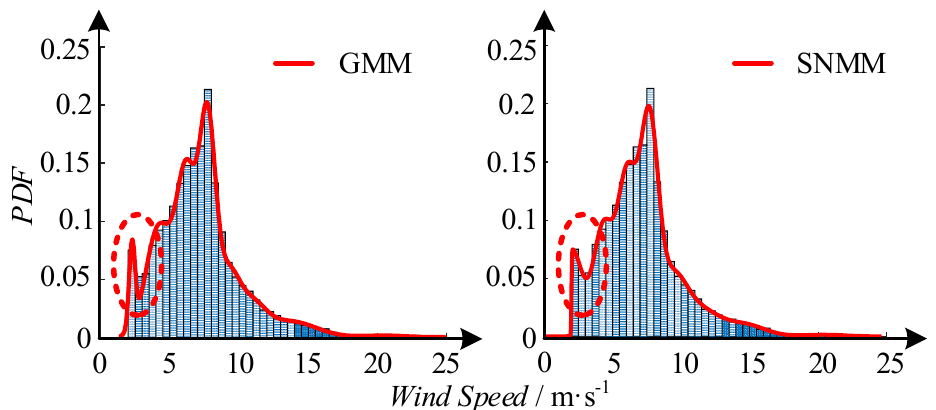
Figure 6. Fitted PDFs of the wind speed at Mazongshan.